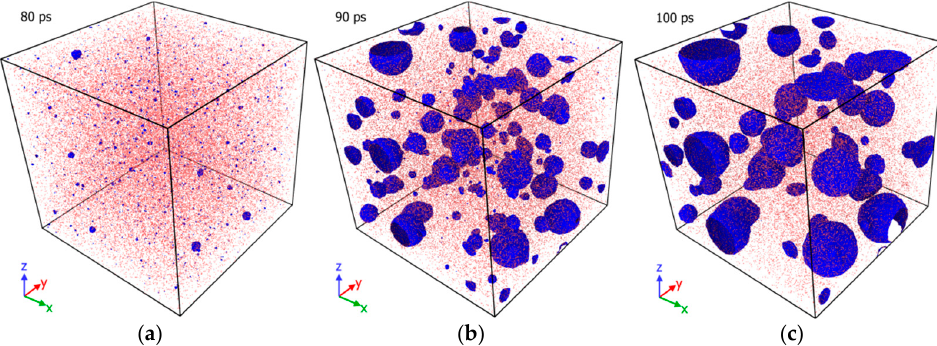
Figure 2. MD simulations of the dynamic tensile fracture of copper melt at 2000 K: ( a ) Homogeneous nucleation of multiple voids; ( b ) Abrupt viscous growth of voids; ( c ) Collapse of small voids and growth of large ones after the relaxation of pressure. The void surfaces and copper atoms with increased energy are shown; MD system with 13.5 million atoms.